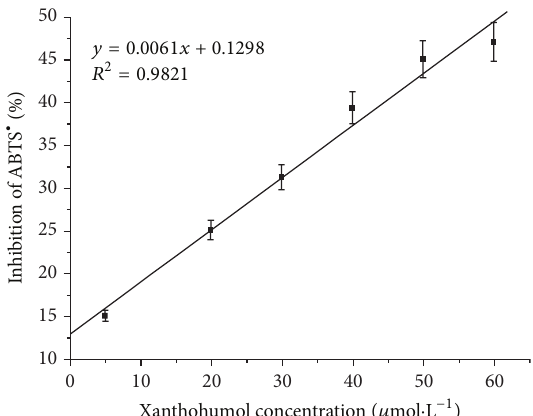
Figure 6: A representative calibration curve of FRAP values by Trolox standards (10, 20, 30, 40, 50, 60 𝜇 mol ⋅ L −1 ). 𝑌 = 0.0094𝑥 − 0.0152 and 𝑅 2 = 0.9992 ( 𝑛 = 3 ).